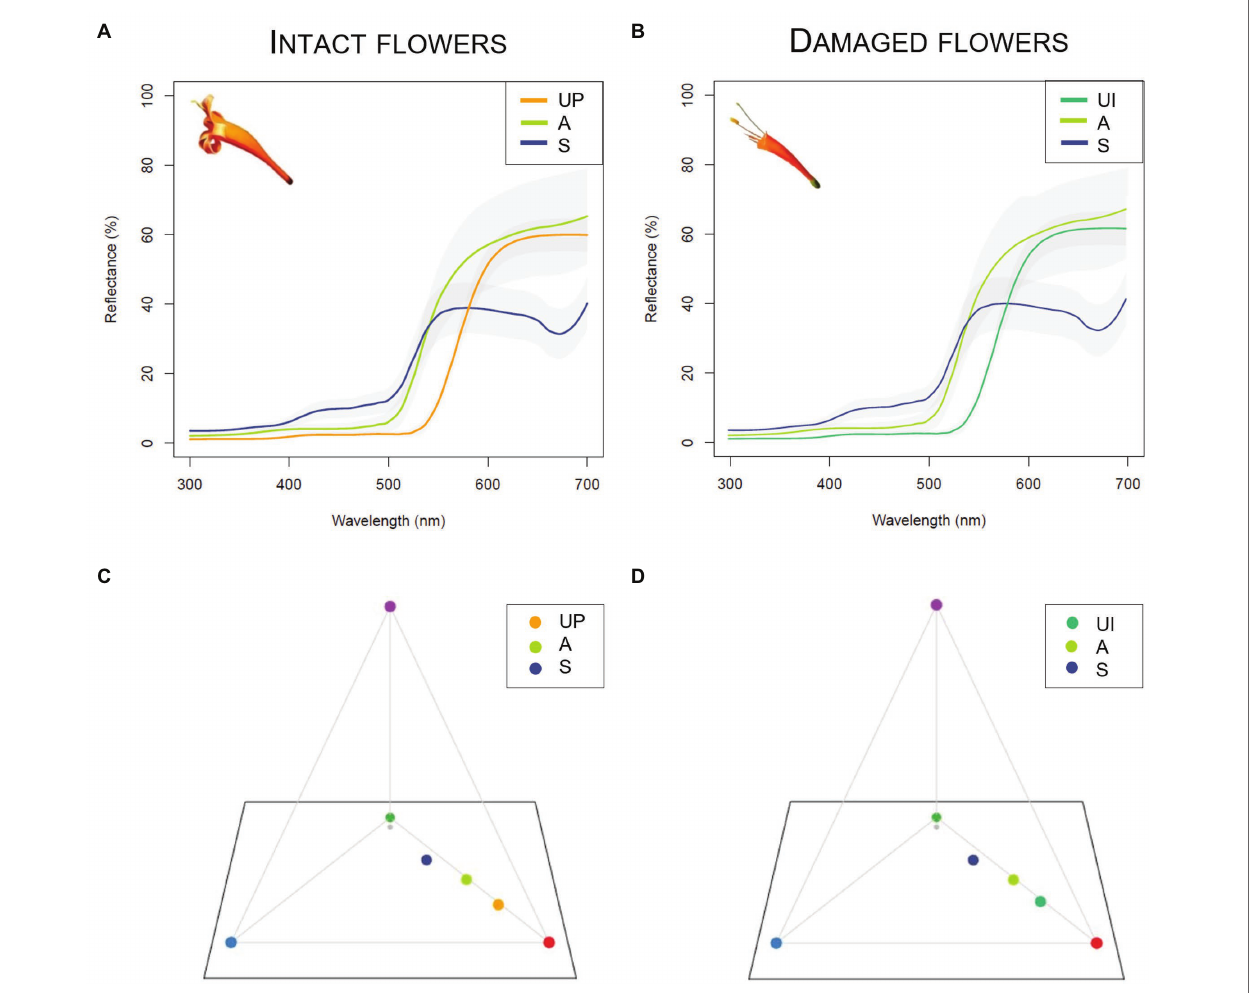
FIGURE 5 | Spectral reflectance of intact and damaged Pyrostegia venusta (Bignoniaceae) flowers ( n = 20 flowers from 8 plants) and colours modelled using the tetrahedron vision model for birds. (A,B) Spectral reflectance curves. The lines represent the mean reflectance of the upper petal lobe (UP), the upper internal portion of the corolla tube (UI), the anthers (A) and the stigma (S). The shaded areas represent the standard variation of reflectance measures. (C,D) Tetrahedron vision model for birds. The central grey dots represent the achromatic center; the coloured dots represent the mean loci for the aforementioned portions of the flowers. The maximum excitation of the ultraviolet, blue, green, and red photoreceptors is represented by the respective tetrahedron vertices (violet, blue, green, and